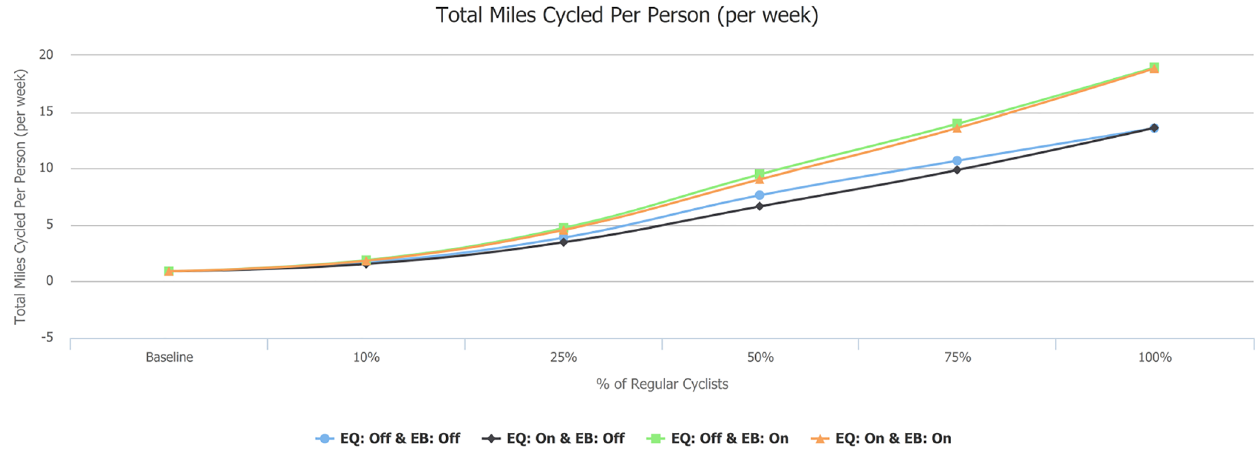
Fig 4. Miles cycled per person per week. EB, e-bikes scenario; EQ, equity scenario.